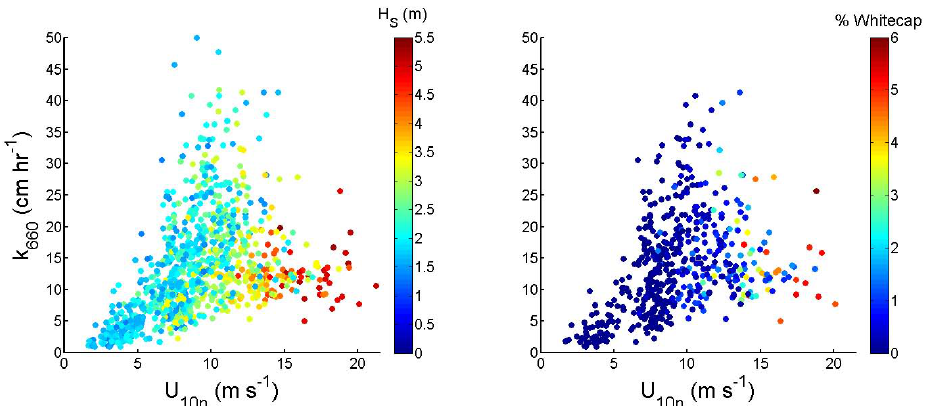
Fig. 7. Knorr_11 gas transfer coefficients plotted as a function of wind speed, with symbol color indicating significant wave height (a) and % whitecap area coverage (b)